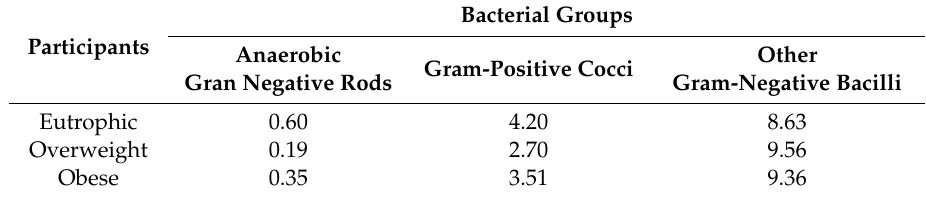
Table 2. Ratios between the absolute numbers of detected antimicrobial resistance genetic markers (ARG) more likely to occur between the di ff erent bacterial groups and the relative frequency of each group, as determined by fluorescence in situ hybridization (FISH) in the faecal metagenome of the